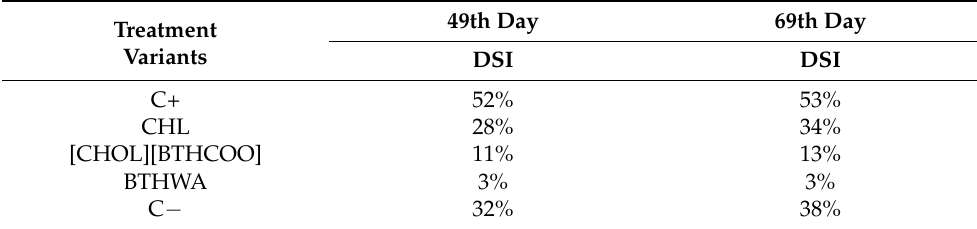
BTHWA C − Disease Severity Index (DSI%).